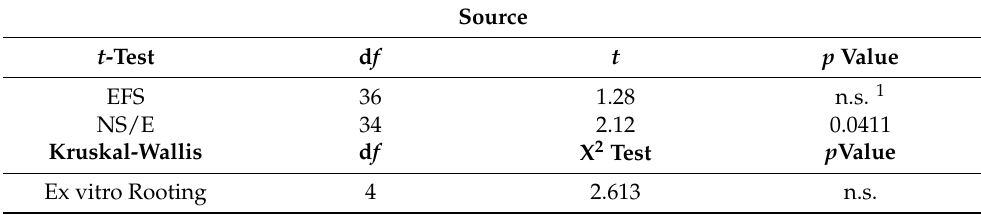
Table 2. T -test analysis of variance for explants forming shoots (EFS) (%) and NS/E (number of shoots formed per explant) of Pinus halepensis apical shoot buds induced under two different concentrations of BA (22 and 44 µ M L − 1 ) and Kruskal–Wallis analyses for ex vitro rooting of five different genotypes (H8, H32, 17-3, P1, P8).